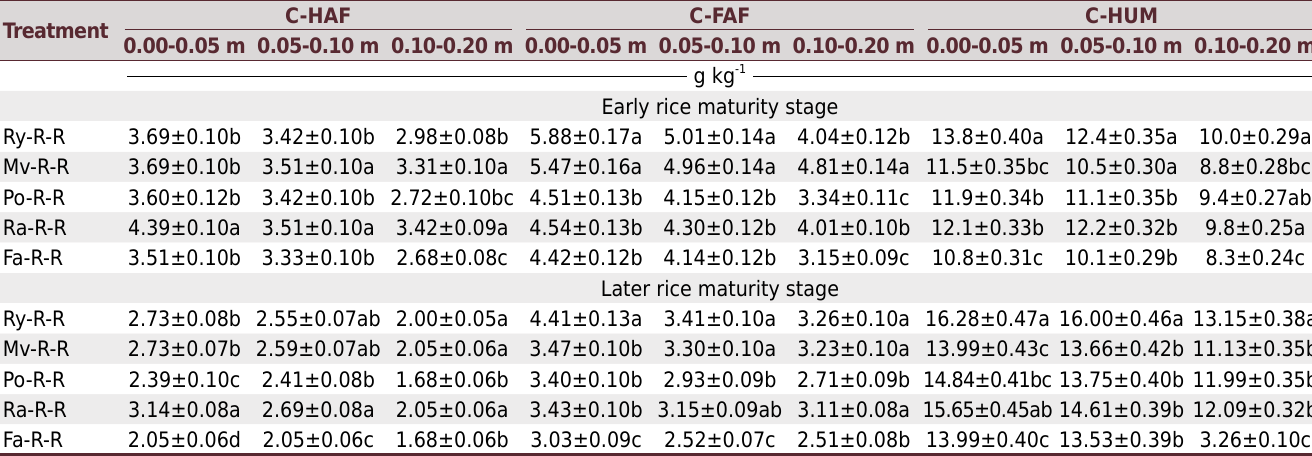
C-HAF: humic acid fraction; C-FAF: fulvic acid fraction; C-HUM: humin. Ry-R-R: rice-rice-ryegrass cropping system; Mv-R-R: rice-rice-Chinese milk vetch cropping system; Po-R-R: rice-rice-potato cropping system; Ra-R-R: rice-rice-rape cropping system; Fa-R-R: rice–rice cropping system with winter fallow. Different letters indicate significance at p<0.05, according to the least significant difference test.